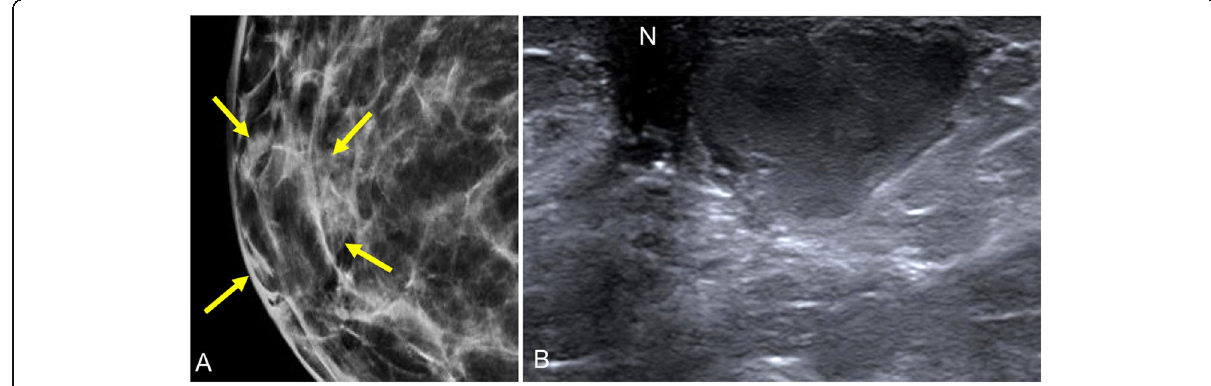
Fig. 28 Epidermal inclusion cyst. A 37-year-old woman with a palpable retroareolar nodule in her right breast, without inflammation. a Synthesized 2D mammogram (craniocaudal view) shows a well-defined isodense nodule measuring 25 mm (arrows) adjacent to the nipple. b Ultrasound shows a well-defined hypoechogenic nodule below the skin of the right areola ( N